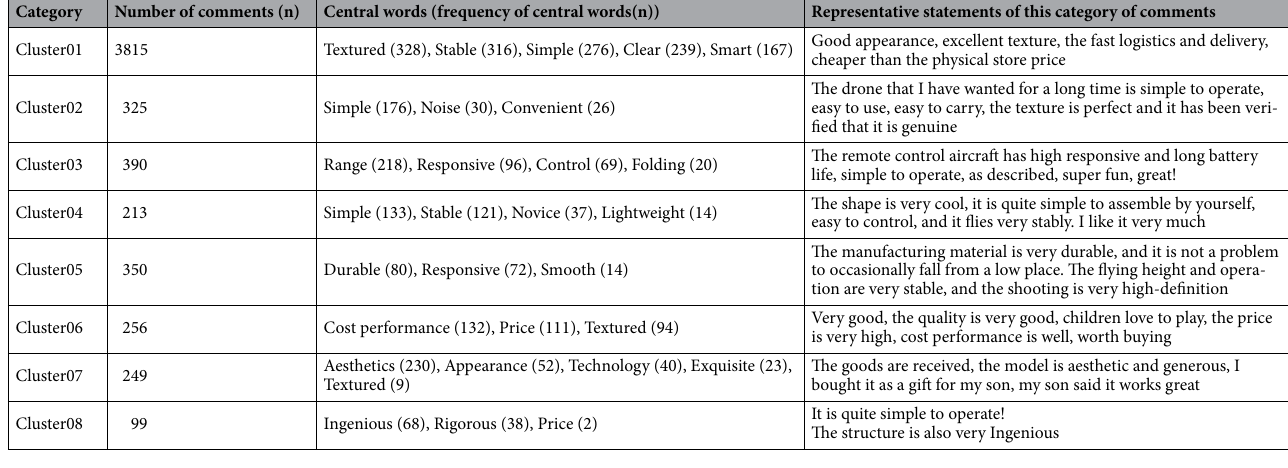
Table 4. K-means clustering